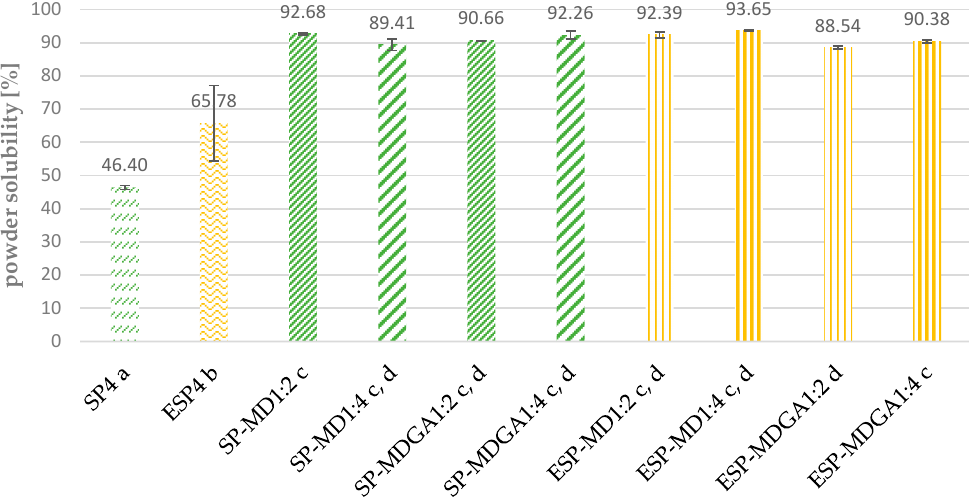
Figure 1. Powder solubility of microencapsulated compared to non-encapsulated Arthrospira platensis . Values with the same lowercase letters (a–d) did not show any significant difference at p < 0.05, according to Tukey’s HSD test.